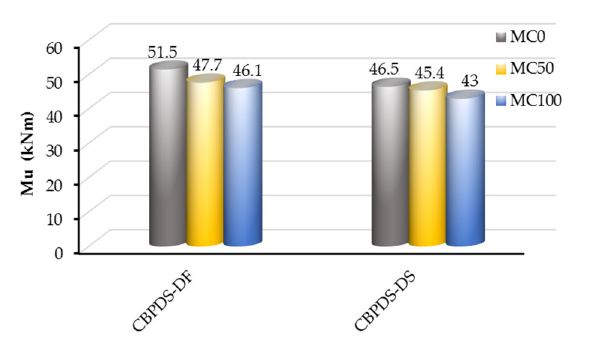
Figure 13. Ultimate moment capacity of specimens.